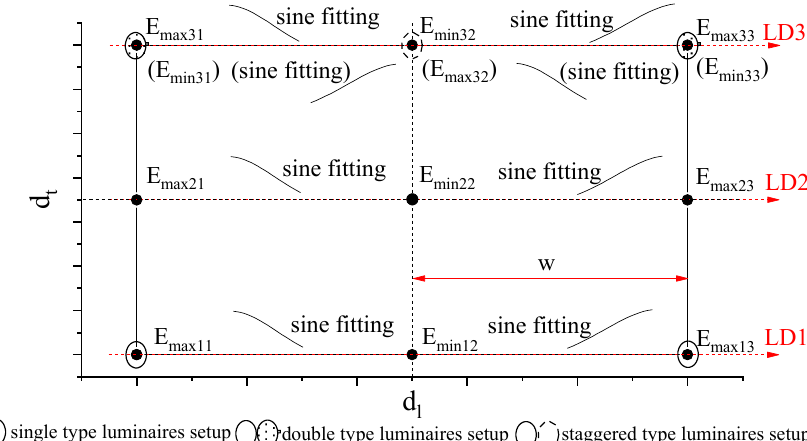
Figure 4. Illuminance modelling using sine functions with feature points between two luminaires of single type, double type, and staggered type. The illuminances in brackets correspond to the staggered type. LD1: Longitudinal Direction No. 1, LD2: Longitudinal Direction No. 2, and LD3: Longitudinal Direction No. 3.